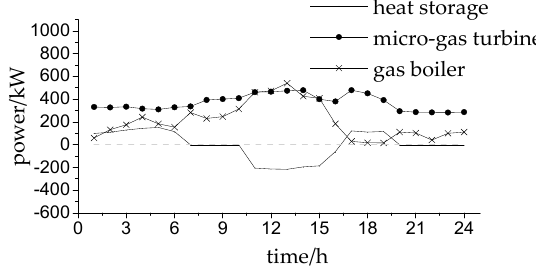
Figure 8. The optimization results of the heating system.